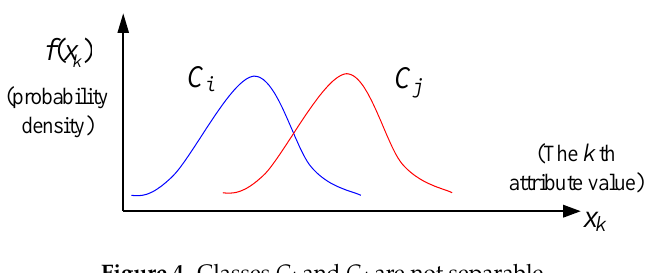
Figure 4. Classes are not separable.